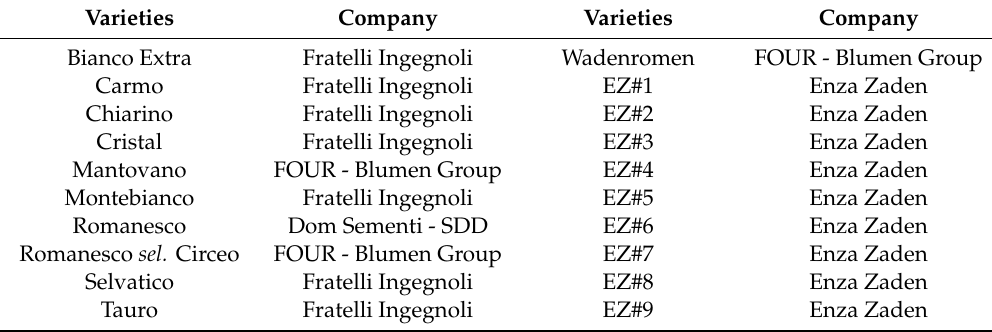
Table 4. Varieties used in this research. Samples provided by Enza Zaden are named EZ coupled with a number and referred to a not declared F 1